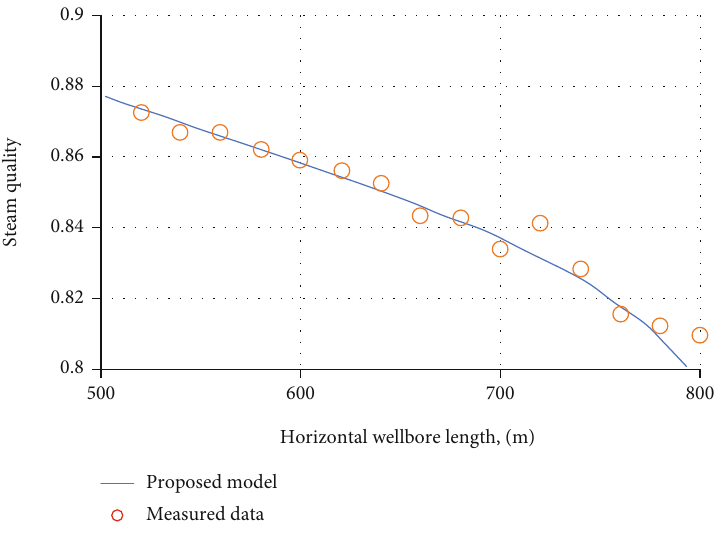
Figure 8: Steam quality along the horizontal